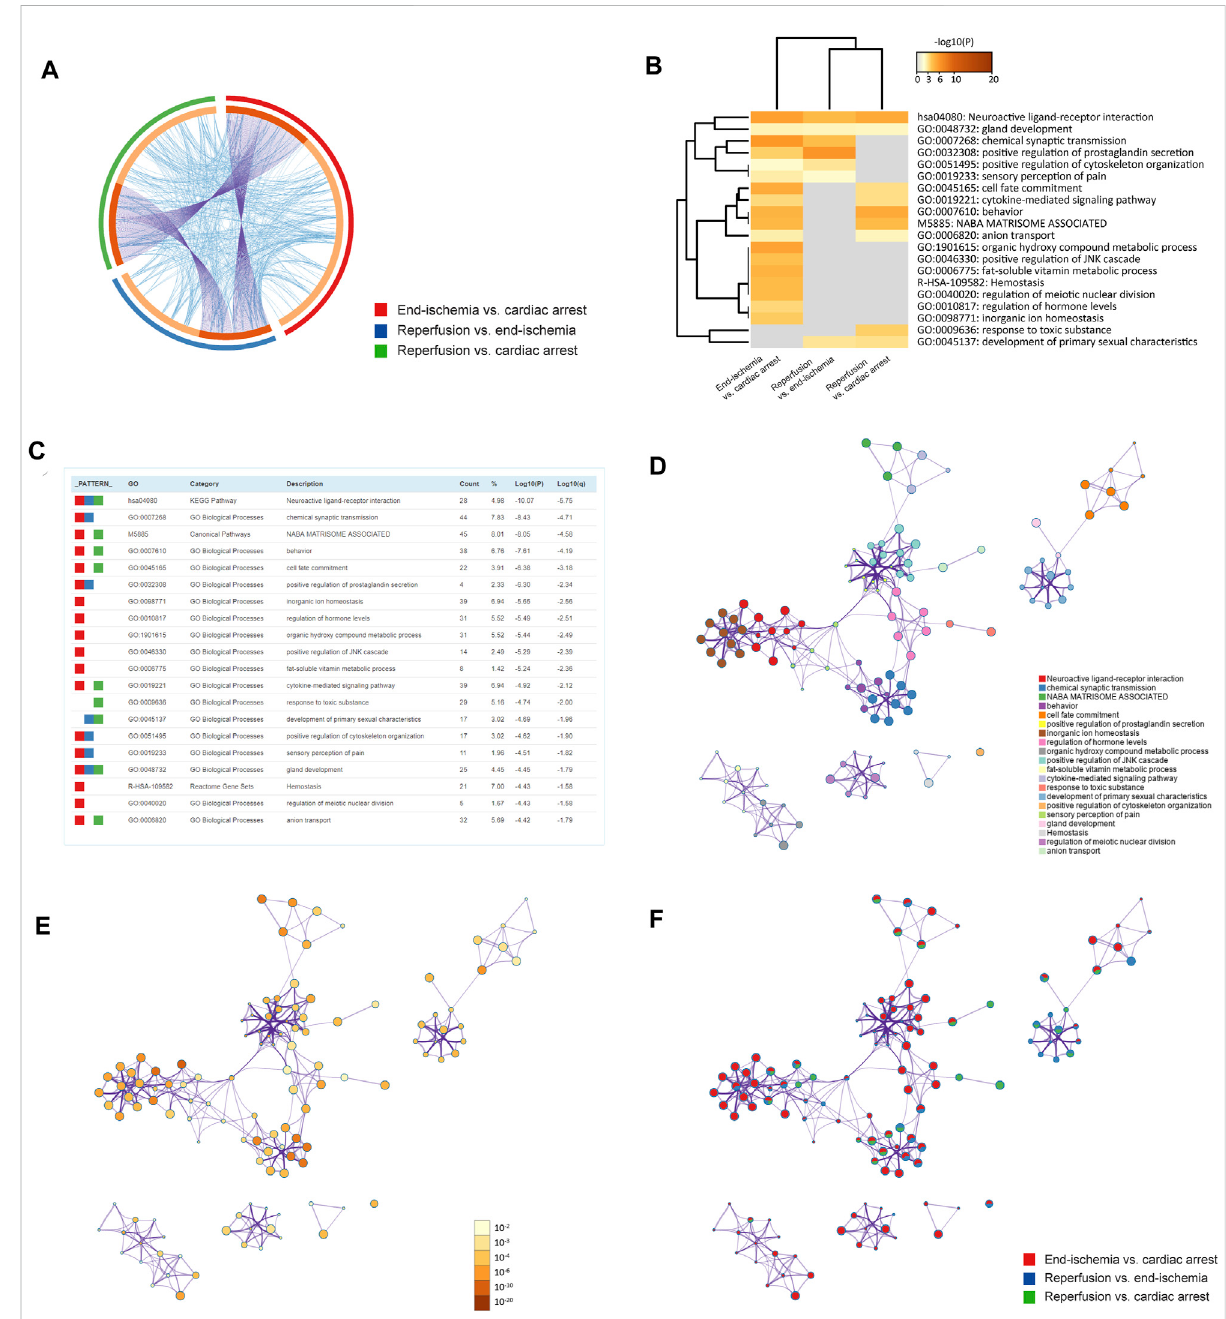
FIGURE 2 Functional enrichment analyses of DEGs. (A) Circos plot showing gene overlaps and genes of the same enriched ontology term. Purple curves link common genes, and blue curves link genes belonging to the same enriched term. Dark orange indicates genes that hit multiple lists, and light orange indicates genes unique to a list. (B) Heatmap showing top 20 enriched terms, colored by p -values. (C) Characteristics of top 20 enriched terms.Count(%)indicatesthenumber(percentage)ofgenesinthegivenontologyterm. (D) NetworkscoloredbyclusterIDs,wherenodeswith the same ID are close to each other. (E) Networks colored by p -values. (F) Networks with pie charts, color-coded by identities of the